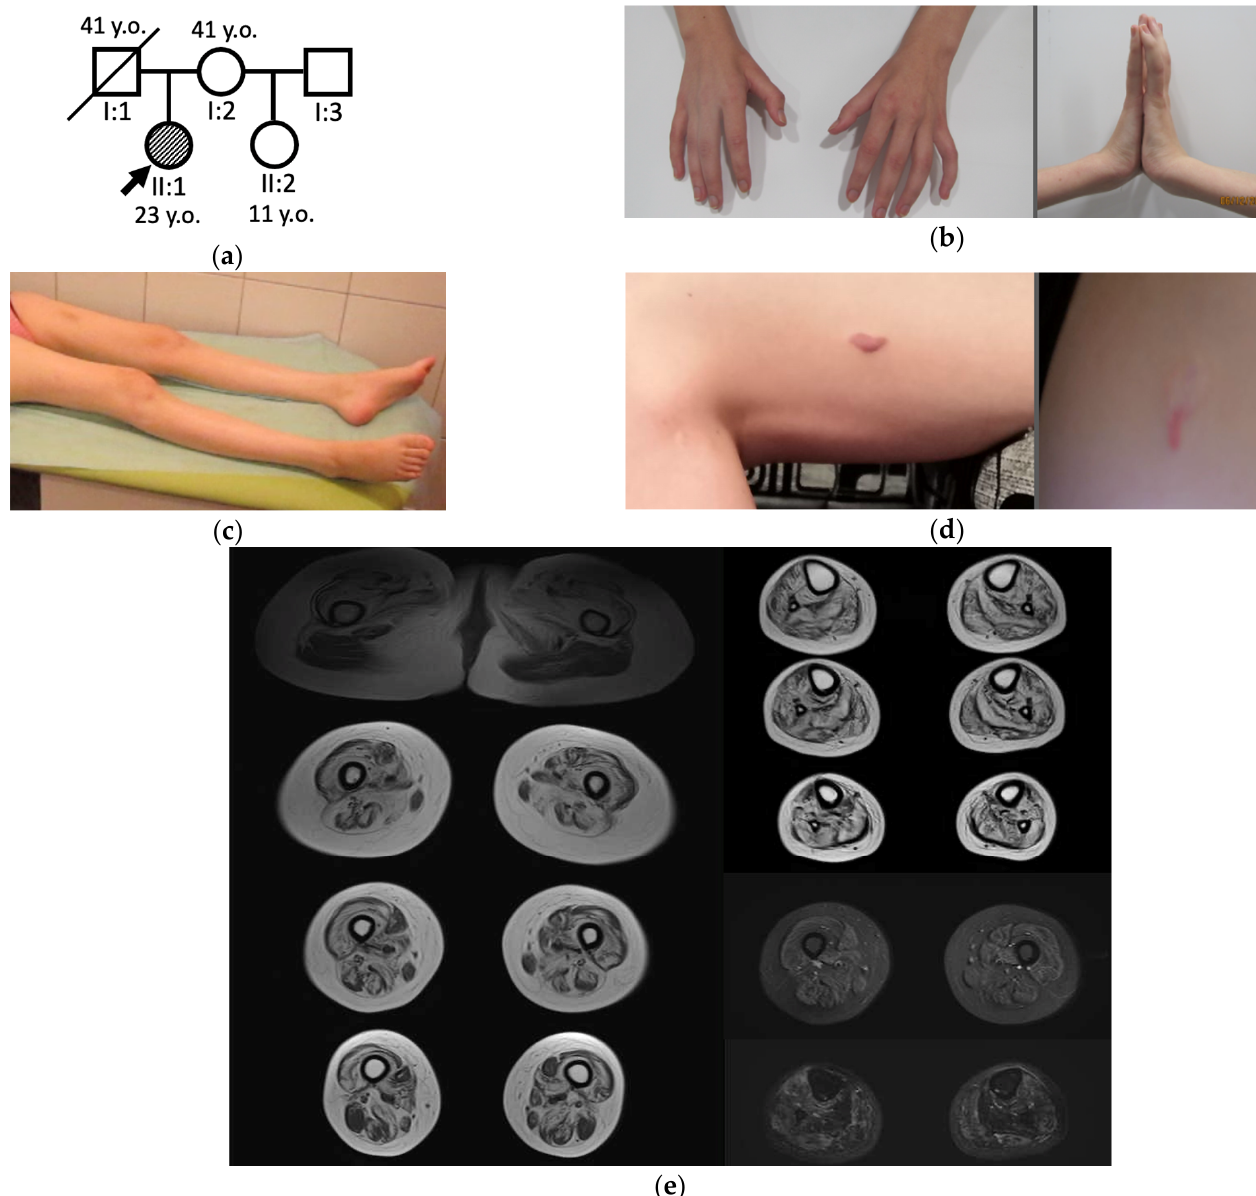
Figure 4. The patient No. 8.1. with atypical GNEM. ( a ) Genealogy; ( b ) Hand muscle atrophy and hand joint contractures; ( c ) Lower limb muscle atrophy; ( d ) Keloid scars on the left thigh and left arm; ( e ) T1-weighted and T2-STIR muscle MR-images of the lower limbs.